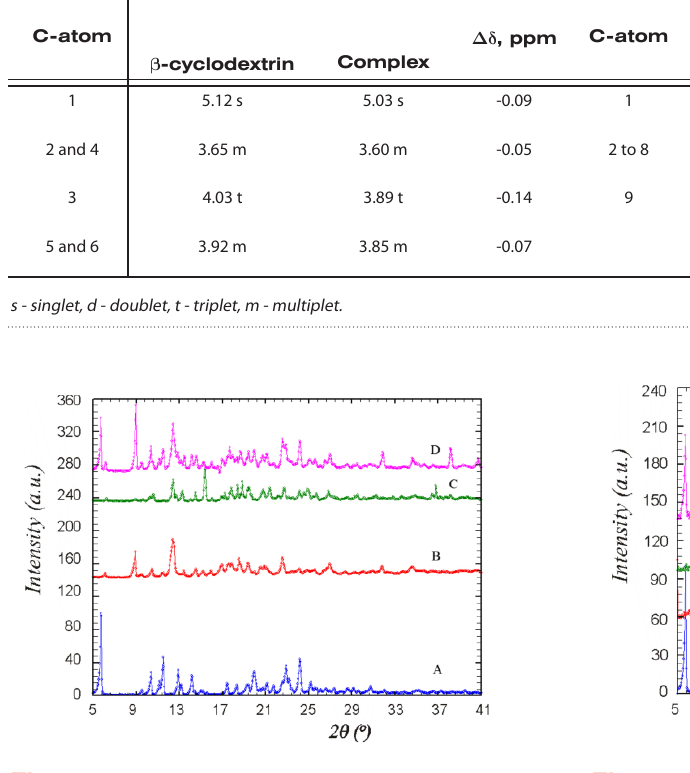
Figure 4a. X-ray diffractograms of amlodipine besylate (A), β-cyclodextrin (B), inclusion complex of amlodipine besylate and β-cyclodextrin (C) and physical mixture of amlodipine besylate and β-cyclodextrin (D).